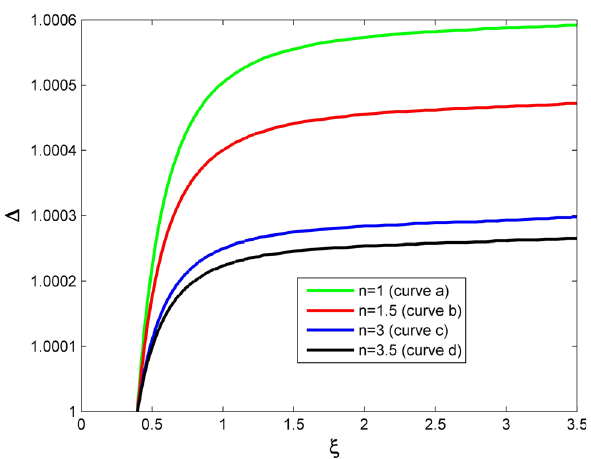
Fig. 3 Graphs between ξ and (cid:7)